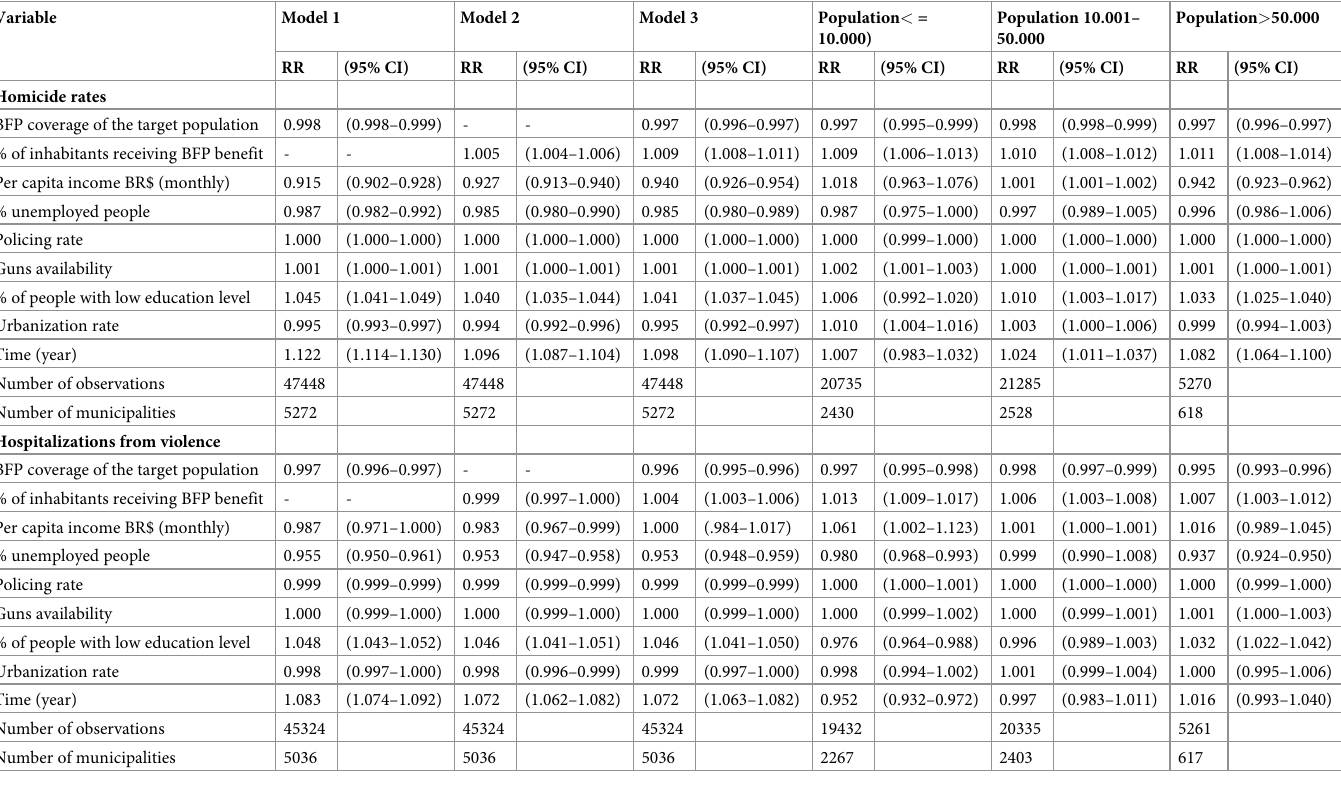
Table 2. Fixed effect regression models for adjusted associations between homicide rates or hospitalizations from violence and BFP coverage and percentage of municipality inhabitants receiving BF in the Brazilian municipalities (as continuous variables), also stratified by municipalities of different population sizes,